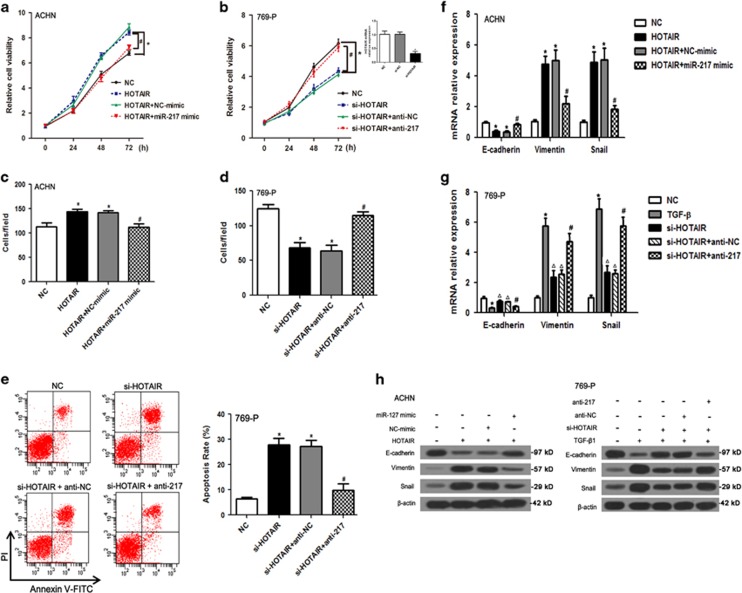
HOTAIR modulates Rcc proliferation, migration, apoptosis, and EMT via negative regulation of miR-217. Cell viability was determined by MTT assay in ACHN (a) and 769-P (b) cells. The inset graph illustrates the efficiency of si-HOTAIR on HOTAIR expression in 769-P cells. Transwell assays were used to analyze the migration of ACHN (c) and 769-P (d) cells. (e) Flow cytometry for apoptosis in 769-P cells. (f) qRT-PCR assay for the mRNA expression of E-cadherin, Vimentin, and Snail in ACHN cells. (g) The mRNA levels of EMT-related genes in 769-P cells. (h) The protein levels of EMT-related genes in Rcc cells. *P<0.05 versus NC group, #P<0.05 versus HOTAIR or si-HOTAIR group, △P<0.05 versus TGF-β group. Data were analyzed using One-way ANOVA